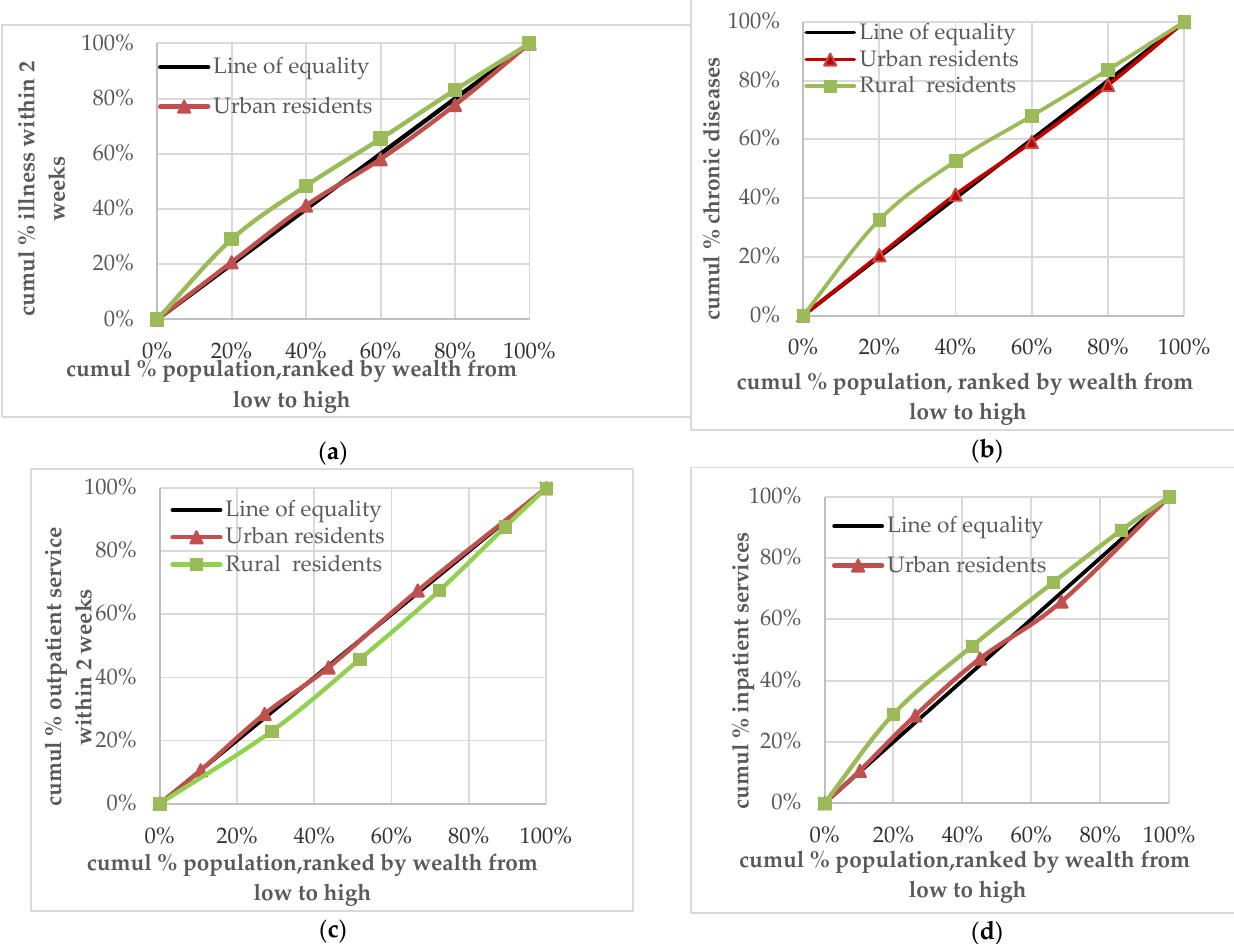
Figure 1. ( a ) Concentration curve of urban and rural residents’ two-week disease prevalence; ( b ) concentration curve of urban and rural residents’ chronic disease prevalence; ( c ) concentration curve of urban and rural residents’ outpatient service utilisation; ( d ) concentration curve of urban and rural residents’ inpatient service utilisation.